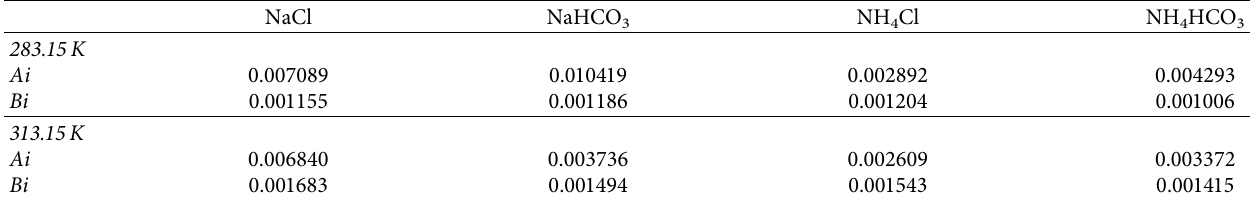
Table 5: Te ftting parameters of the refractive and density at 283.15, 313.15 K, and 0.1MPa a .